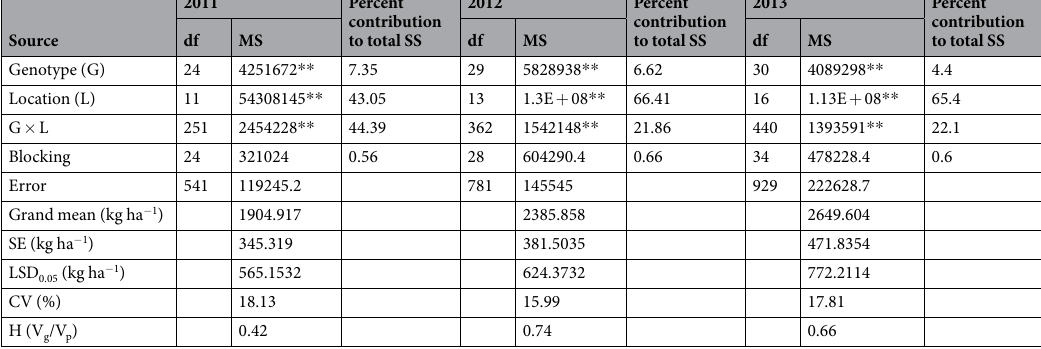
Table 1. ANOVA and basic statistics in individual years (2011, 2012, and 2013). df = degrees of freedom; MS = mean square; SS = sum of squares; ** = significant at 1% level of probability.